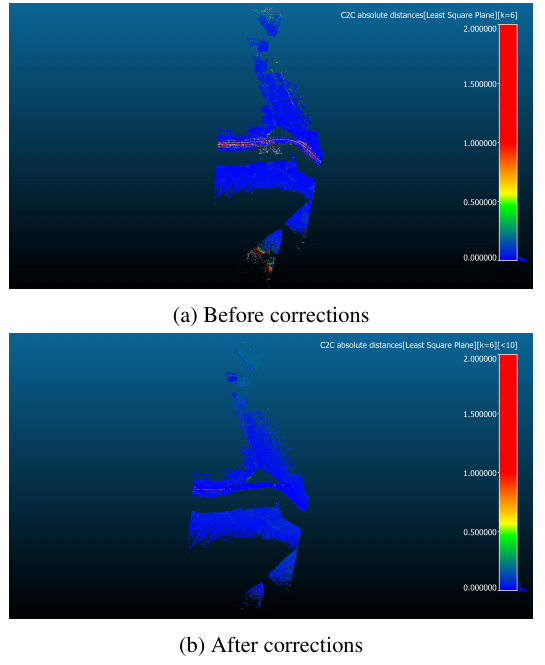
Figure 7: Change analysis from cloud-to-cloud distance applying the point cloud relative corrections described in Section 3.3.